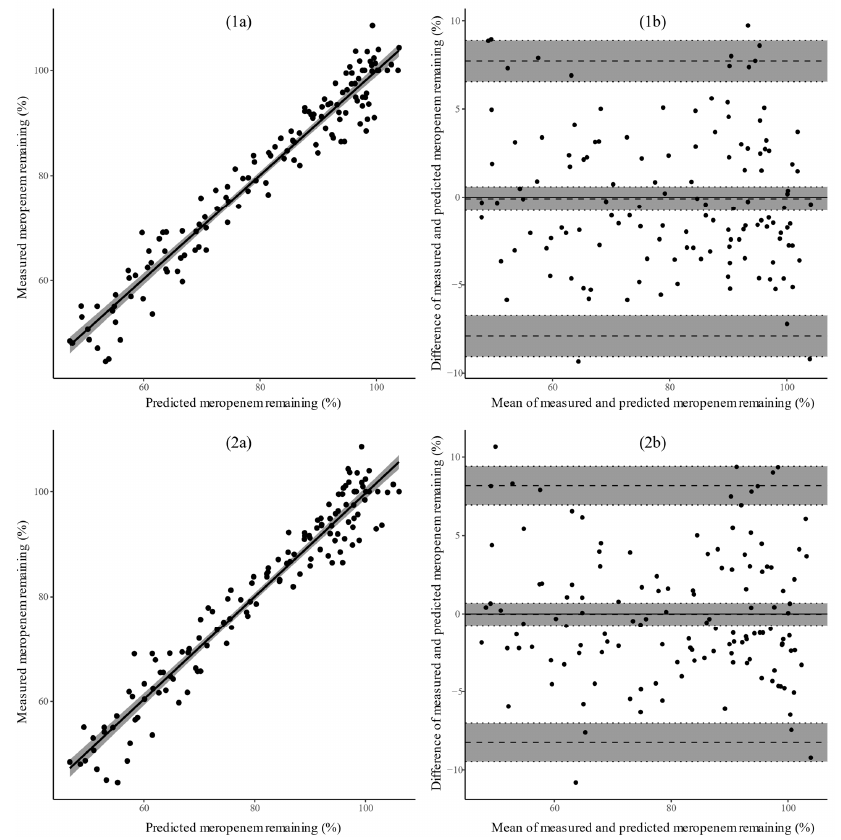
Figure 4. Assessment of the correlation ( left ), r , between the predicted degradation and experimentally measured degradation for the ANN ( 1a ) and polynomial model ( 2a ). The straight black line corresponds to the best linear fit, while the gray shaded area visualizes the 95% confidence interval. Two-sided t -tests were computed to evaluate the null hypothesis that the predictions and observations are not linearly related. Assessment of the agreement ( right ) between the predicted degradation and experimentally measured degradation for the ANN ( 1b ) and polynomial model ( 2b ) by means of a Bland–Altman plot. The dashed horizontal lines correspond to the bias and limits of agreement (±1.96 SD), while the gray shaded area visualizes the 95% confidence intervals. Two-sided t -tests were computed to evaluate the null hypothesis that the mean difference between the predictions and observations is zero (no bias). All results were derived from predictions on the left-out test experiment, i.e., measured concentrations that the model has never seen (see Section 4.6).